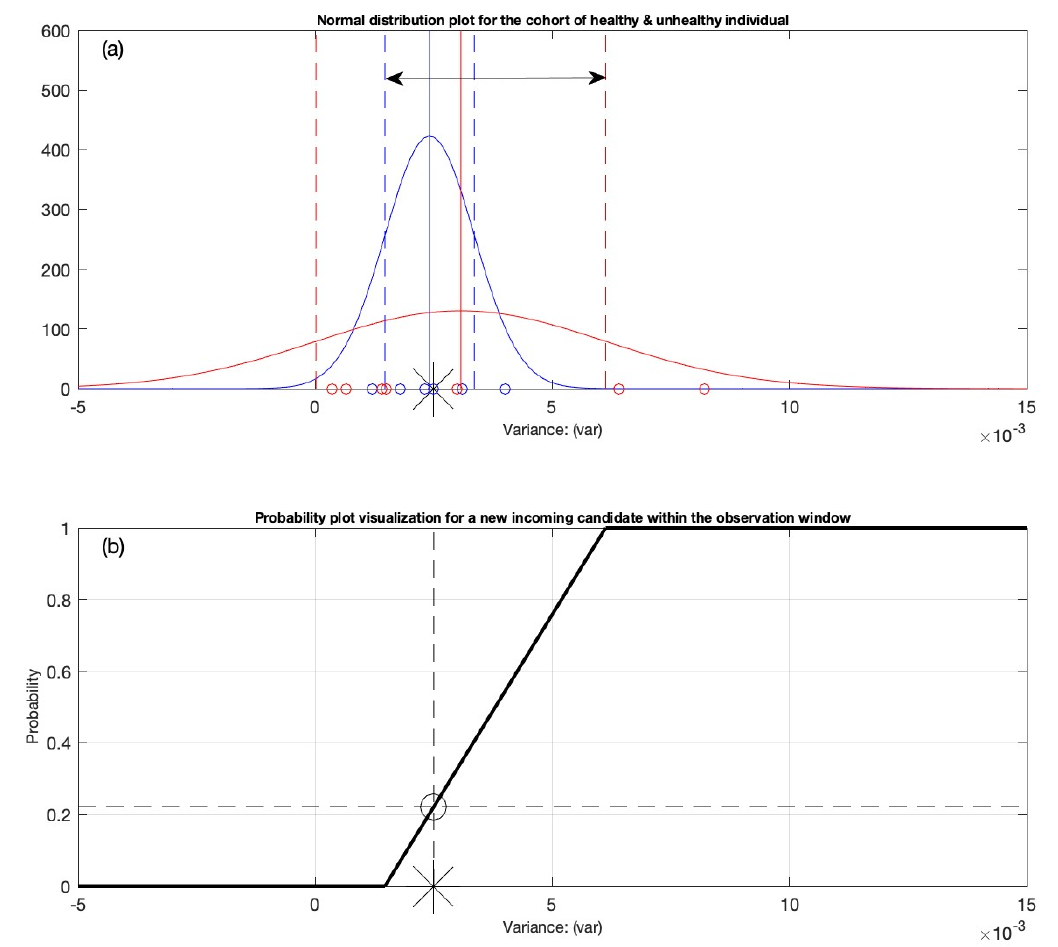
Figure 5. ( a ) The construction of the variation interval between the mean of the healthy distribution minus the standard deviation of the healthy distribution, and the mean of the unhealthy distribution plus the standard deviation of the unhealthy distribution. The variation interval is indicated by a double arrow and is used for the classification of a new incoming candidate. ( b ) The decision support system is depicted as a probability distribution plot with a candidate’s likelihood (0.22) of having AF, indicated by an asterisk